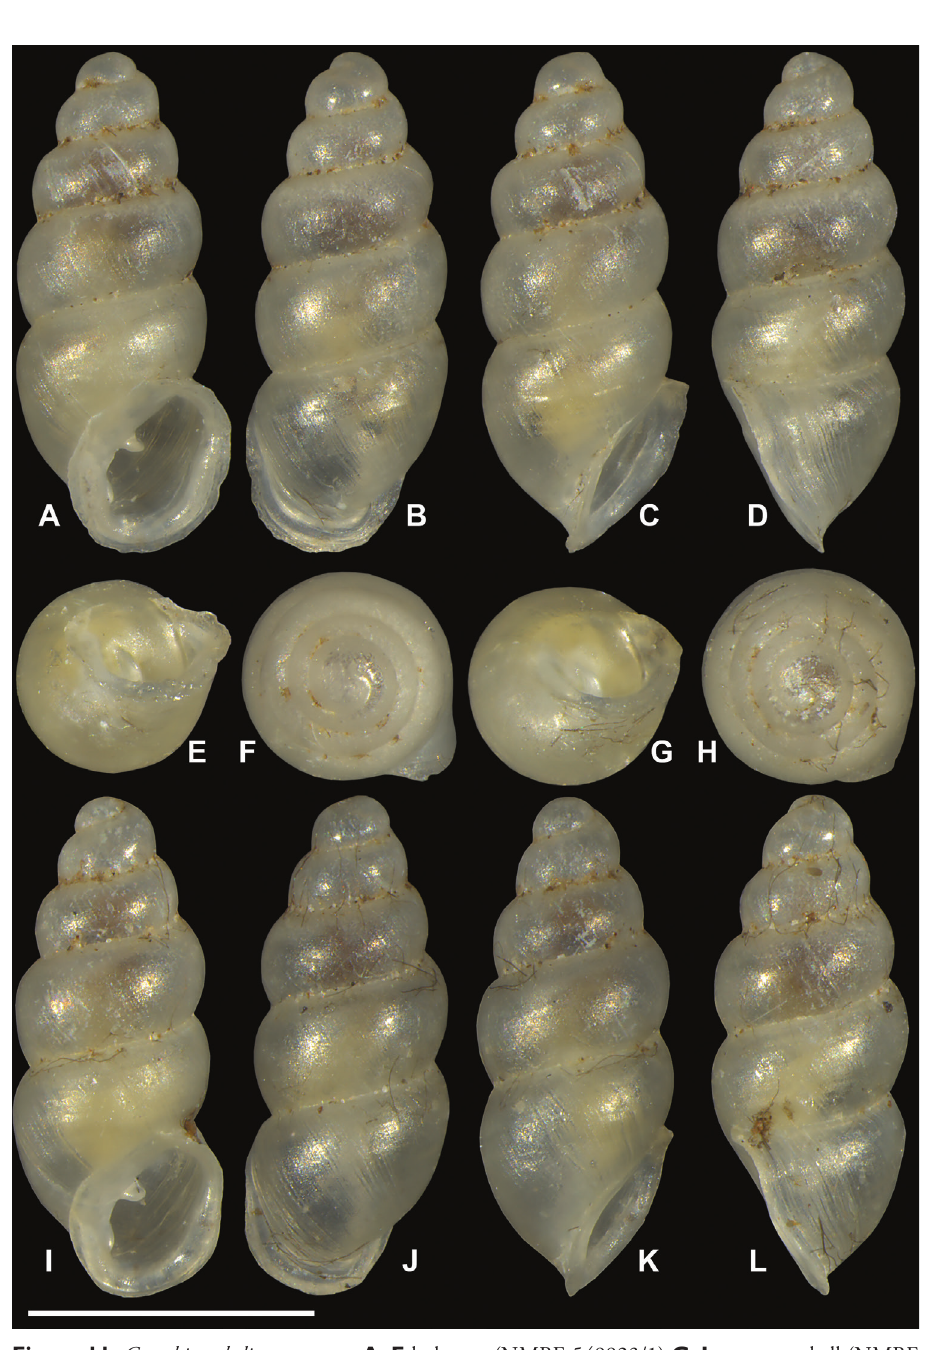
Figure 11. Carychium belizeense sp. n. A–F holotype (NMBE 549923/1) G–L paratype shell (NMBE 549924/8) A, I prominent parietal denticle and parieto-columellar callus. Scale bar 1